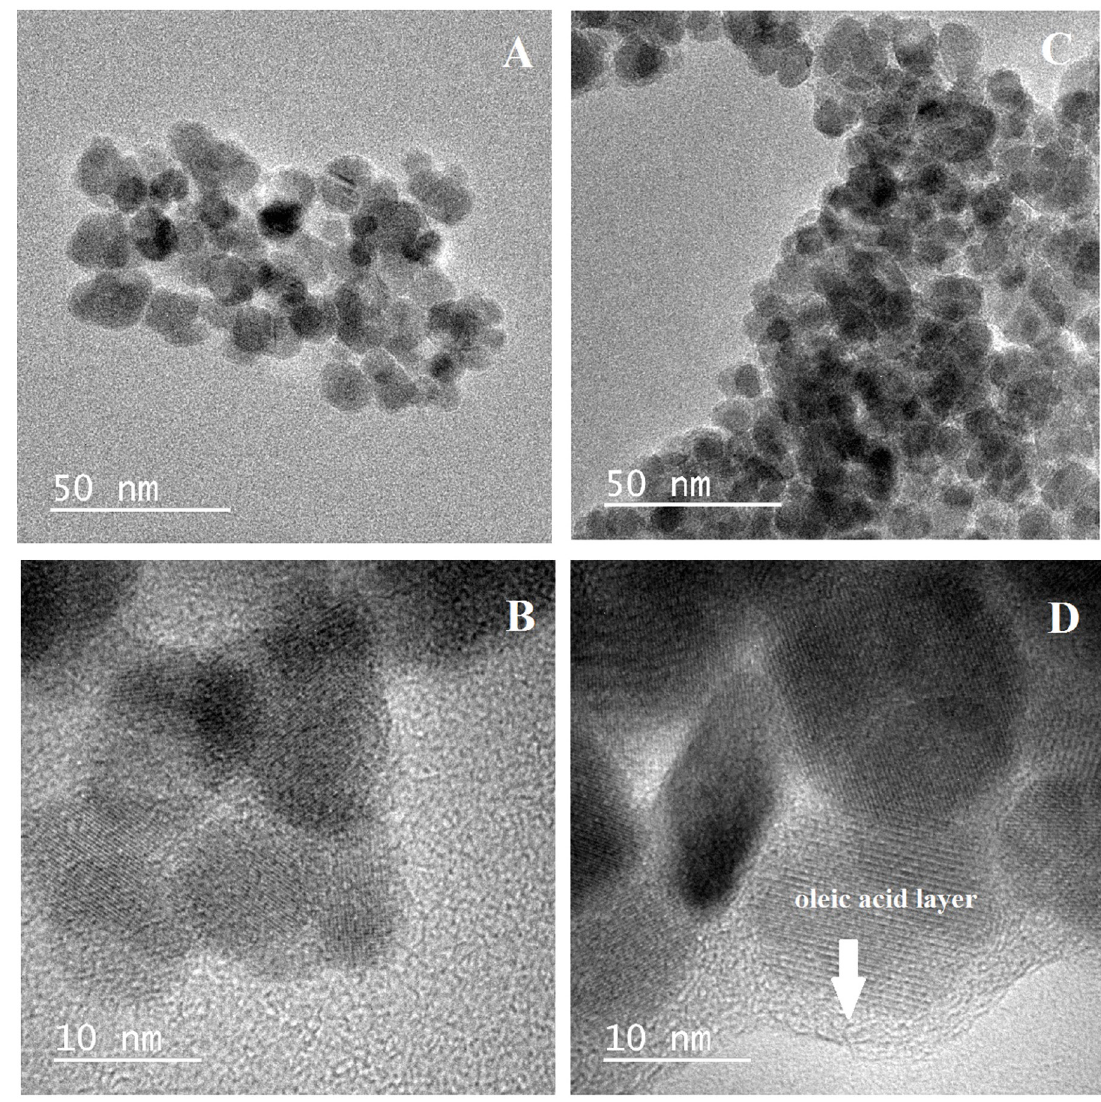
Figure 1. Transmission electronic microscopy images of the hydrophilic nanoparticles (A and B) and the hydrophobic nanoparticles functionalized with oleic acid (C and D). spinel structure. This structure is characteristic of magnetite (Fe O ) or maghemite (γ-Fe O ), not being possible to 3 4 2 3 identify which of the phases is present or if both phases are present in the material. The diffractograms of hydrophilic and hydrophobic nanoparticles are similar, indicating that the functionalization process with oleic acid did not modify the crystallography character of the magnetic nanoparticles.